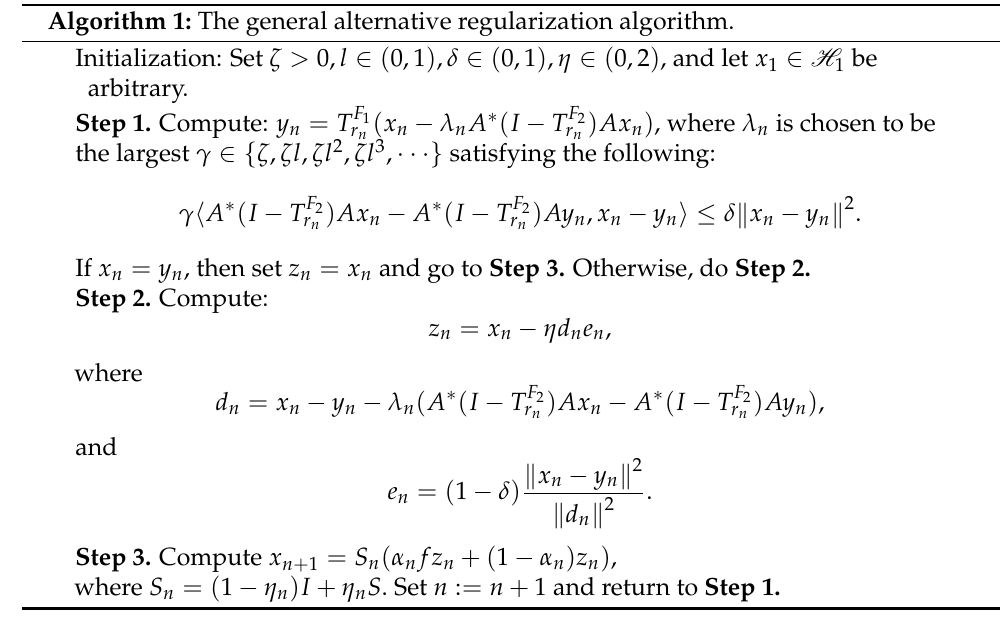
Algorithm 1: The general alternative regularization